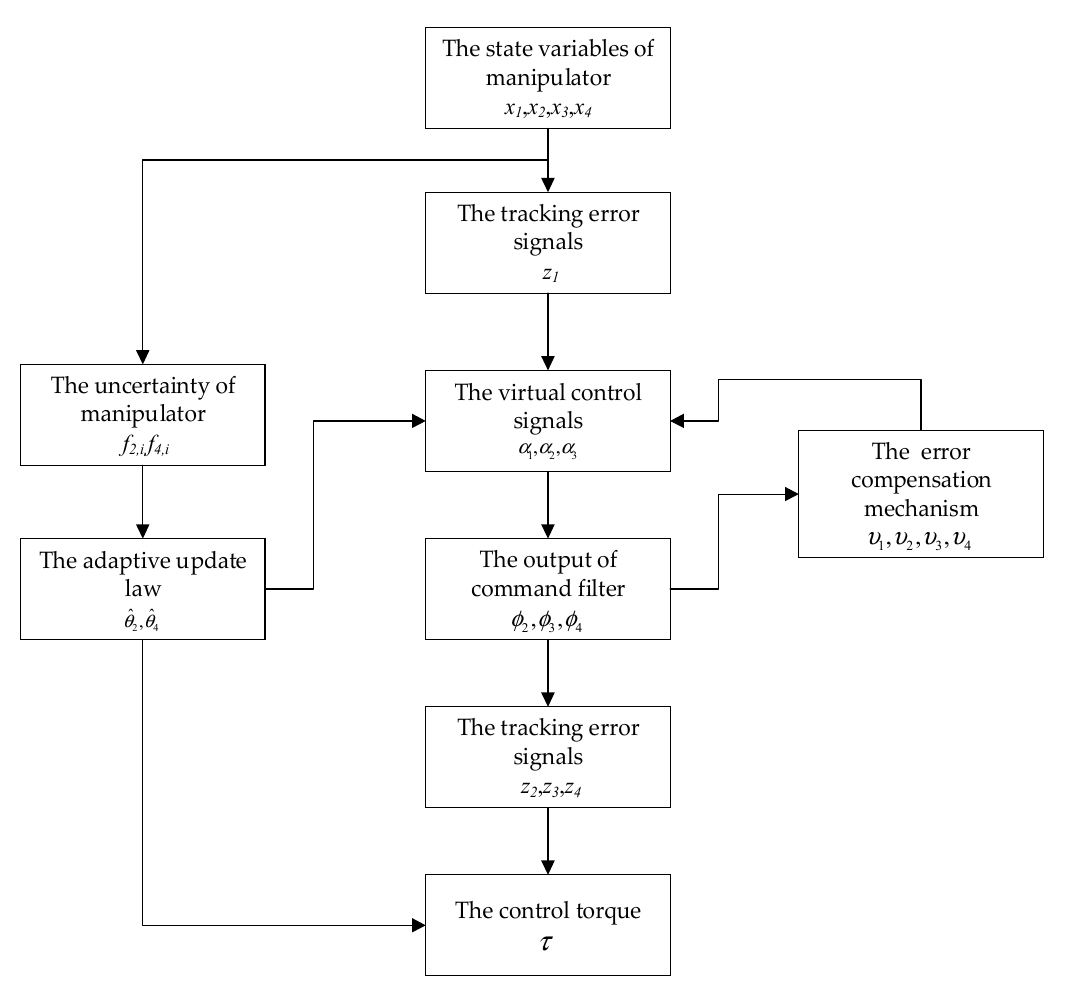
The structure diagram of the control system is shown in Figure 2.